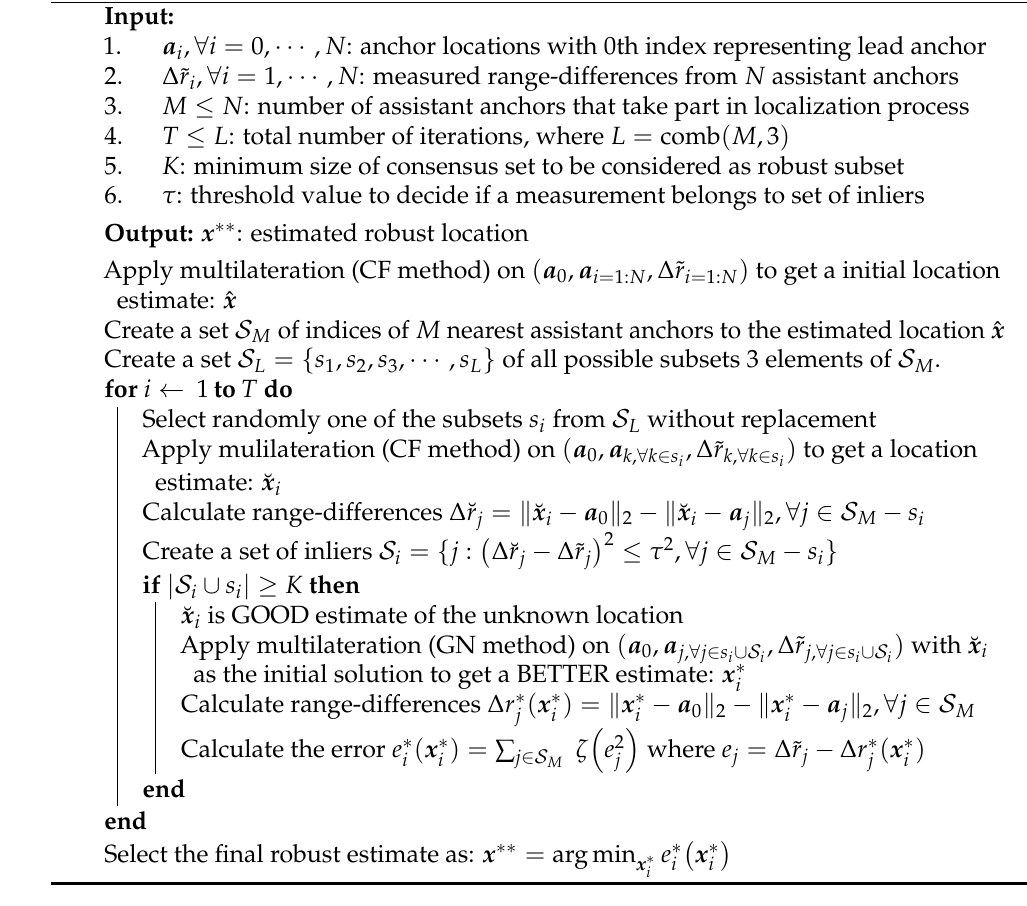
Algorithm 3: RANSAC Robust Location